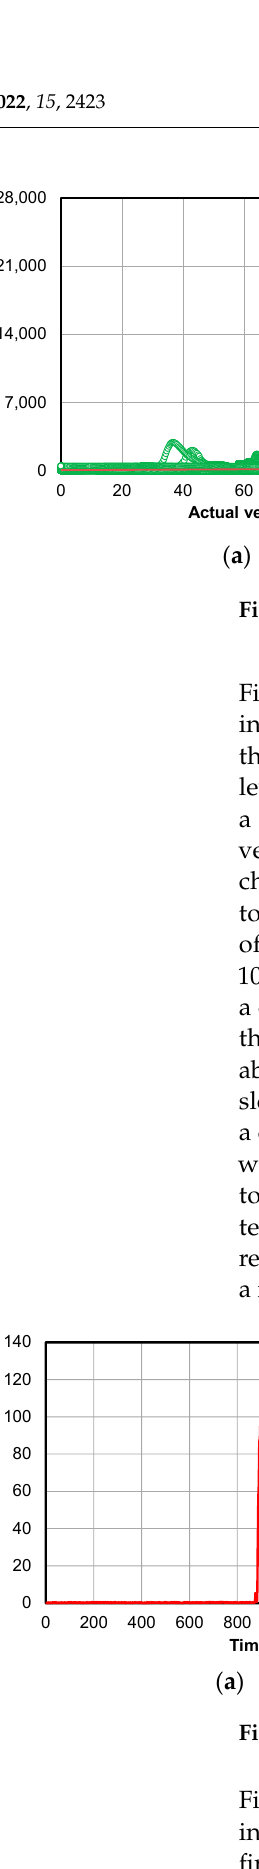
first half of the test, such a concentration was equal to zero due to driving with an electric